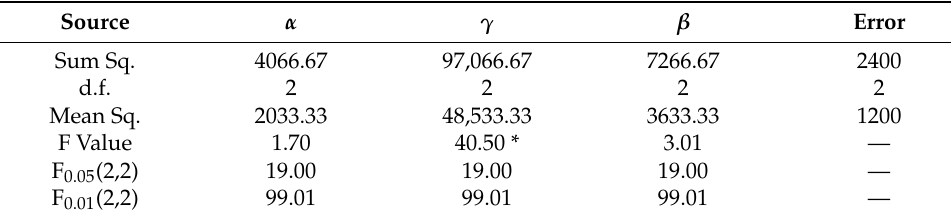
Table 7. Significance test of the bow configuration parameters to the ice resistance. Source α γ β Error Sum Sq. 4066.67 97,066.67 7266.67 2400 d.f. 2 2 2 2 Mean Sq. 2033.33 48,533.33 3633.33 F